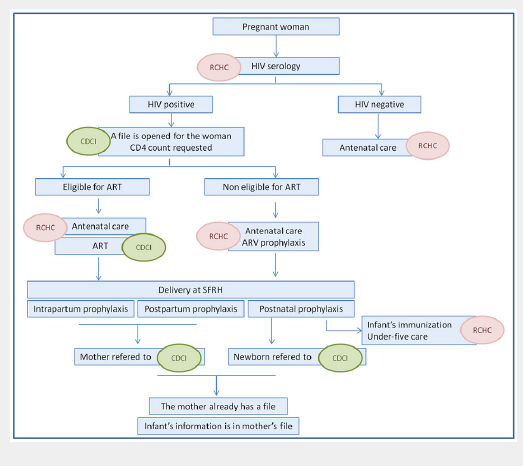
Table 1: Options for preventing mother-to-child transmission of human immunodeficiency virus. Woman receives Treatment (CD4 counts ≤350 cells/mm 3 ) Option